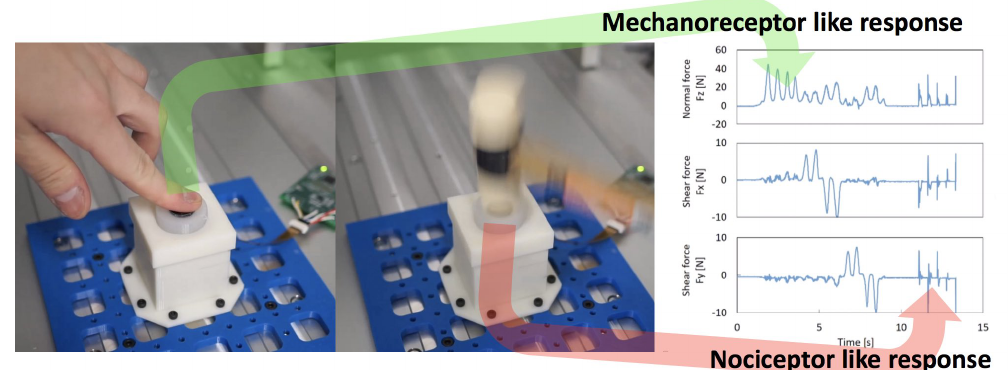
Figure 7. A soft tactile sensor that discriminates soft and hard touches as a mechanoreceptor and nociceptor,